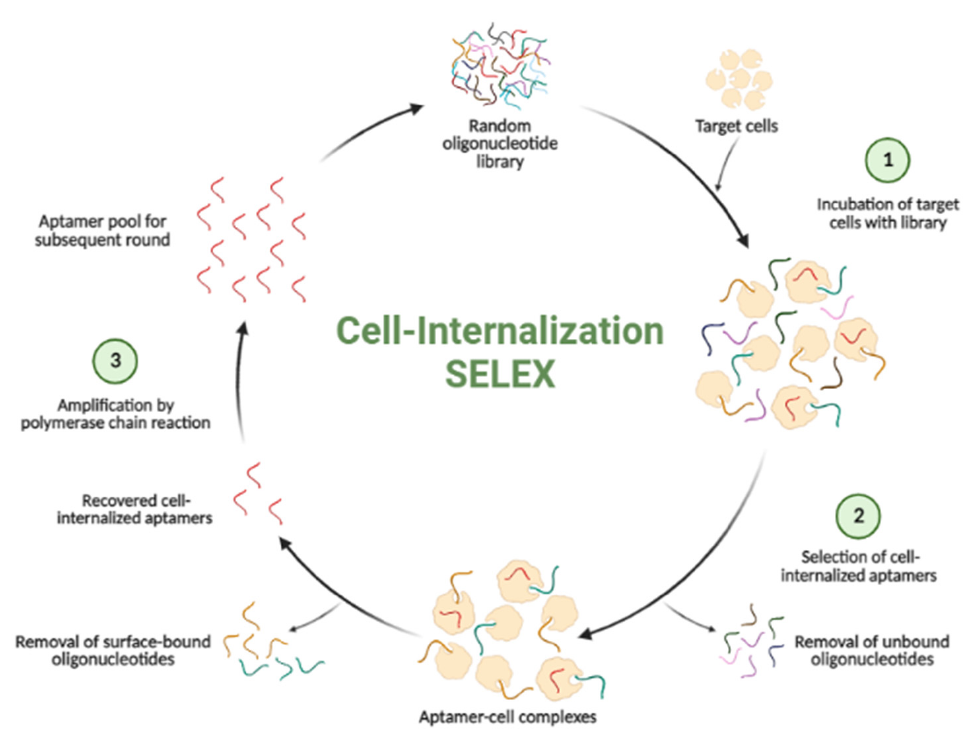
Figure 2. A schematic illustration of cell-internalization SELEX. (Created in BioRender.com, accessed on 9 September 2022).